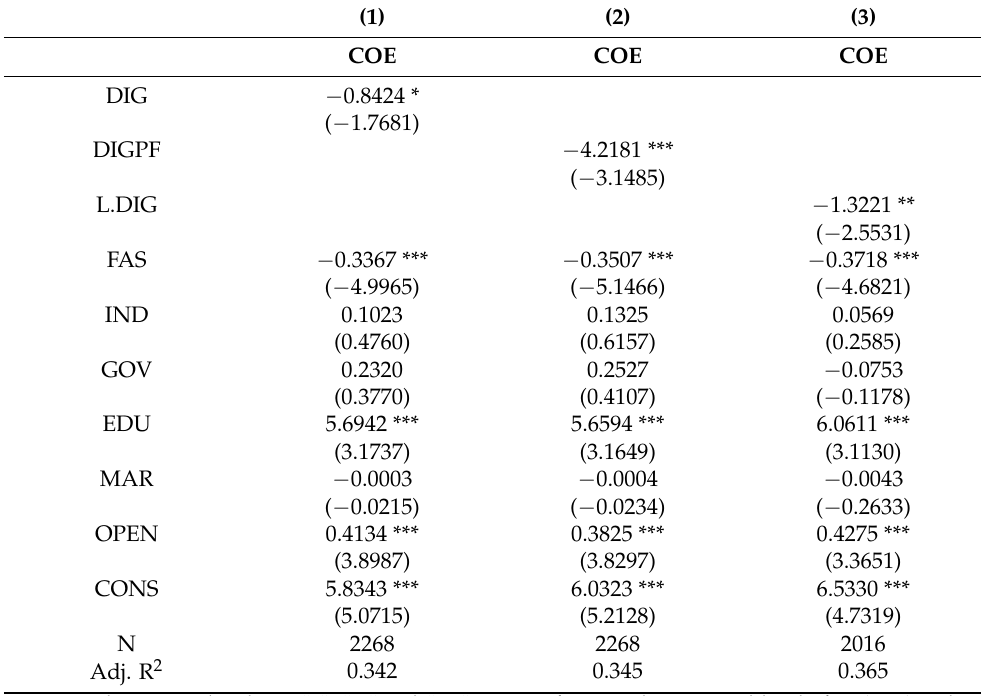
Table 7. Robustness test excluding provincial capitals and municipalities.